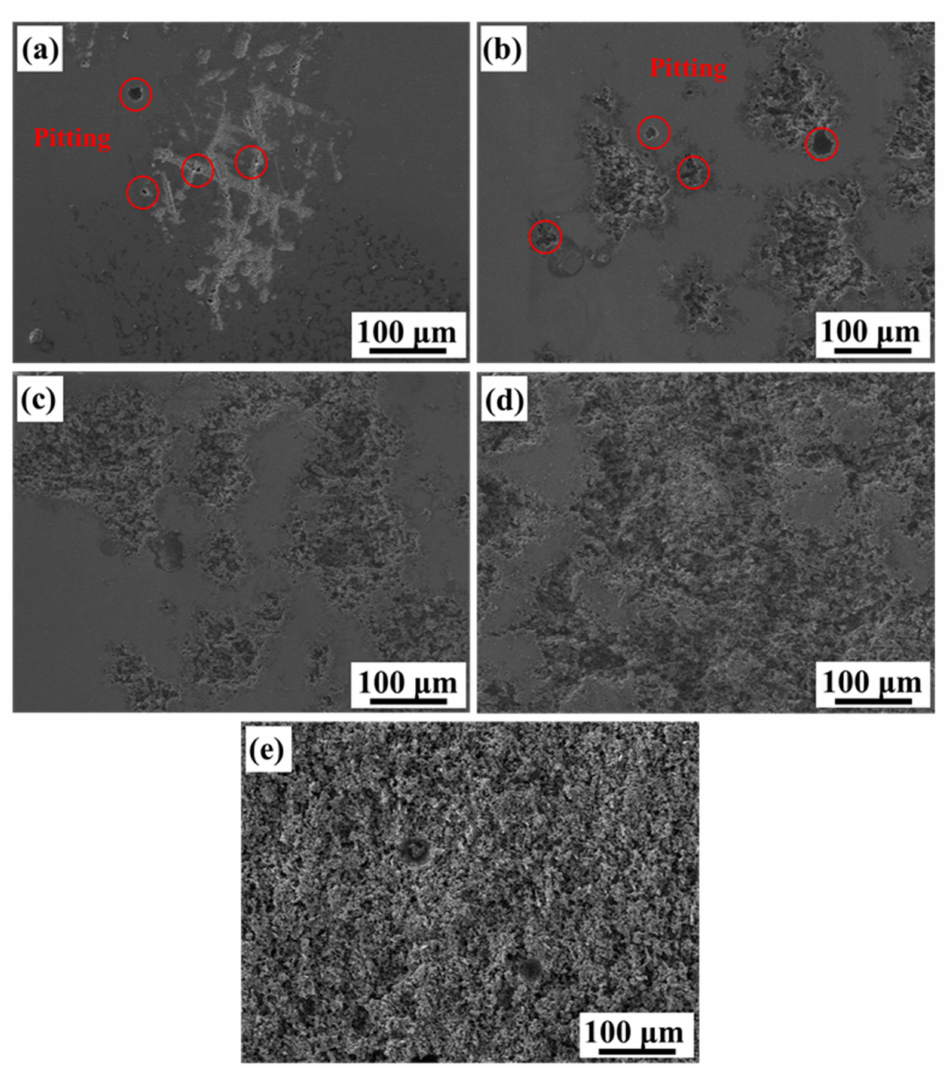
Figure 7. SEM images of the alloys after polarization experiments in the aerated 3.5 wt.% NaCl solution: ( a ) Alloy A, ( b ) Alloy B, ( c ) Alloy C, ( d ) Alloy D, ( e ) Alloy